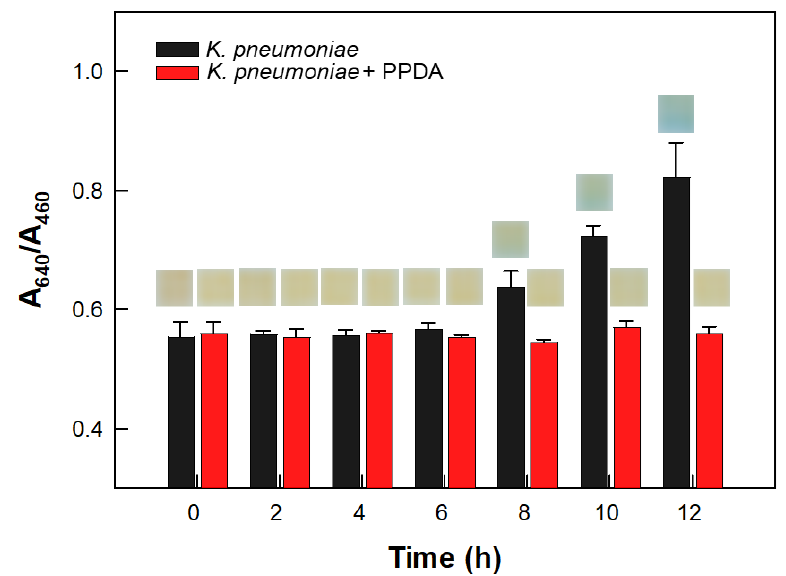
Figure 5. Verification of ureolytic activity in Klebsiella pneumoniae ( K. pneumoniae ) using a urease inhibitor, namely phenyl phosphorodiamidate (PPDA). The A 640 /A 460 values and photographs (in insets showing colors) of film sensors in the absence and presence of PPDA are presented.